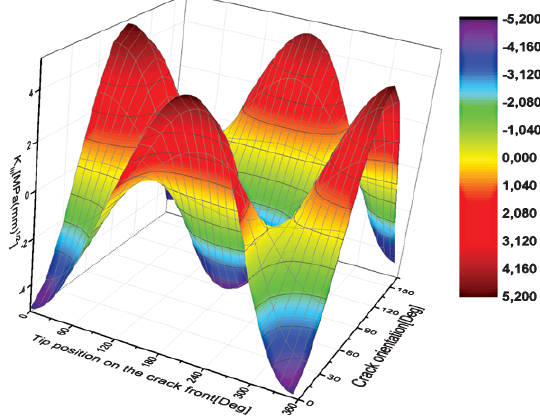
Fig. 16. K III distribution on the crack front as function of the crack orientation in the pos1 in cement